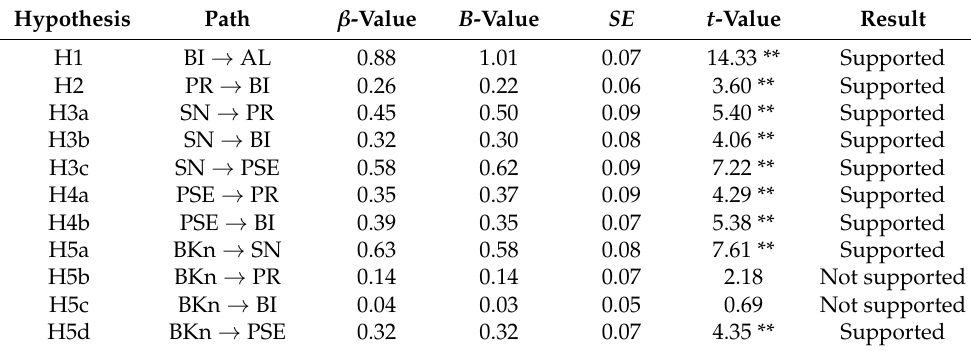
Table 4. SEM results ( n =